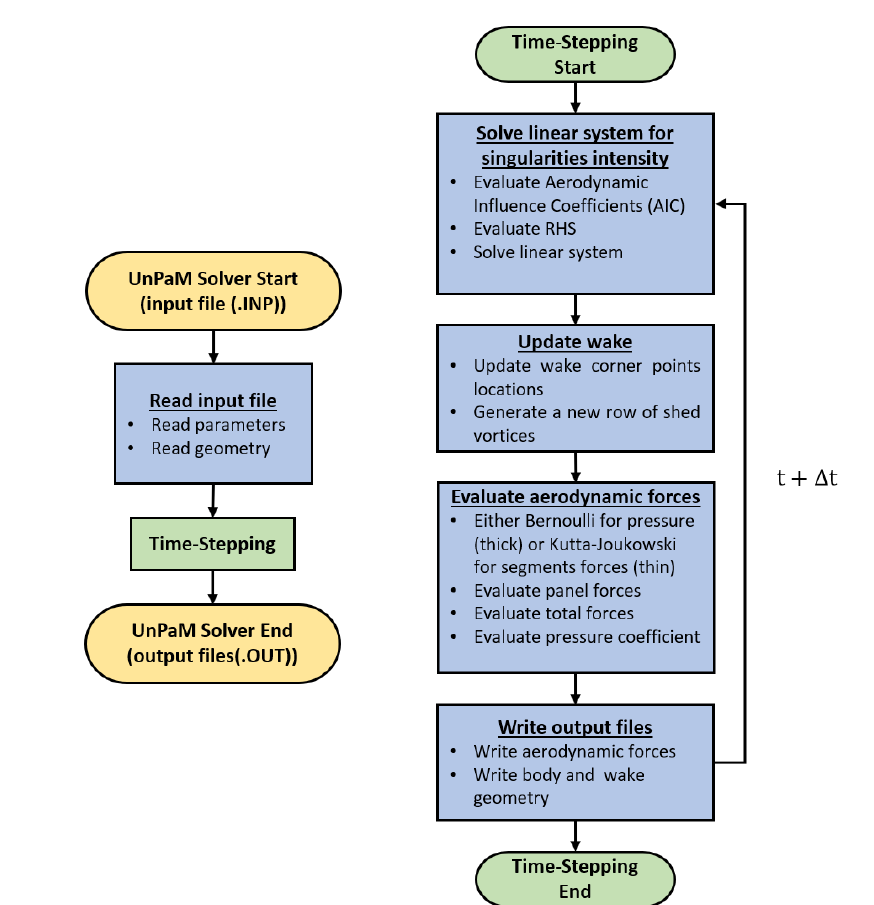
Figure A1. High-level flowchart of UnPaM in unsteady